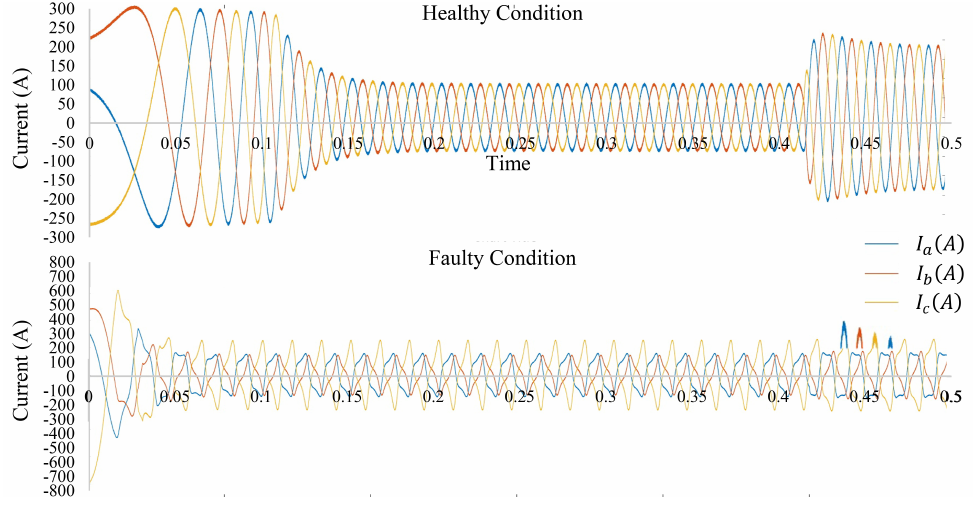
Figure 9. Fault detection when the line-to-ground fault occurs in I c